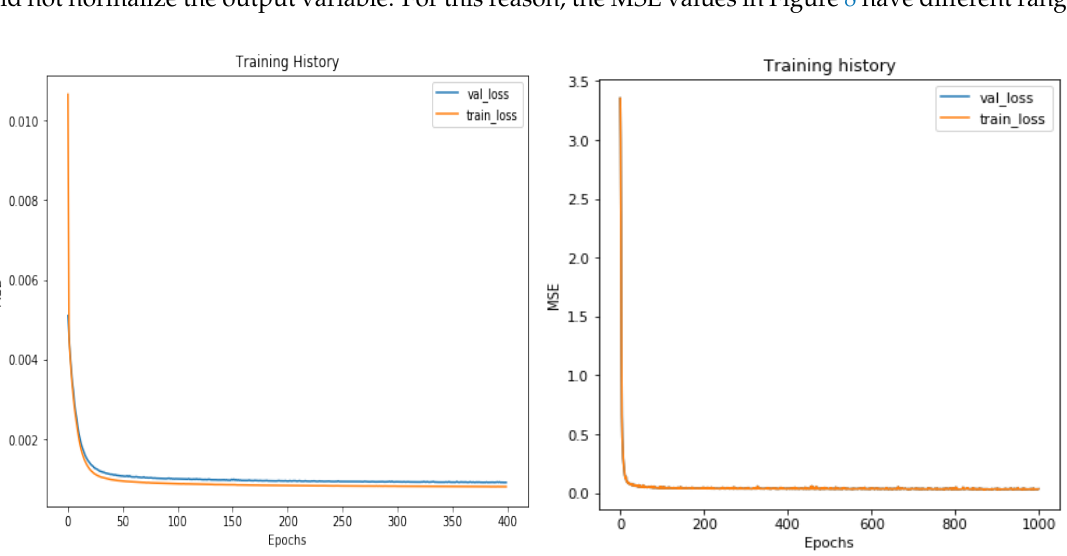
Figure 8. Learning curves of NN models. NN Model 1 (on the left) and NN Model 2 (on the right). As in NN Model 1, the output is scaled put prices and in NN Model 2 unscaled put prices; the MSE values are not